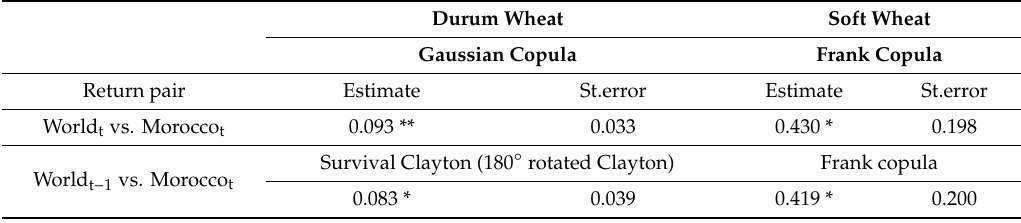
Table 7. Copula parameters and standard